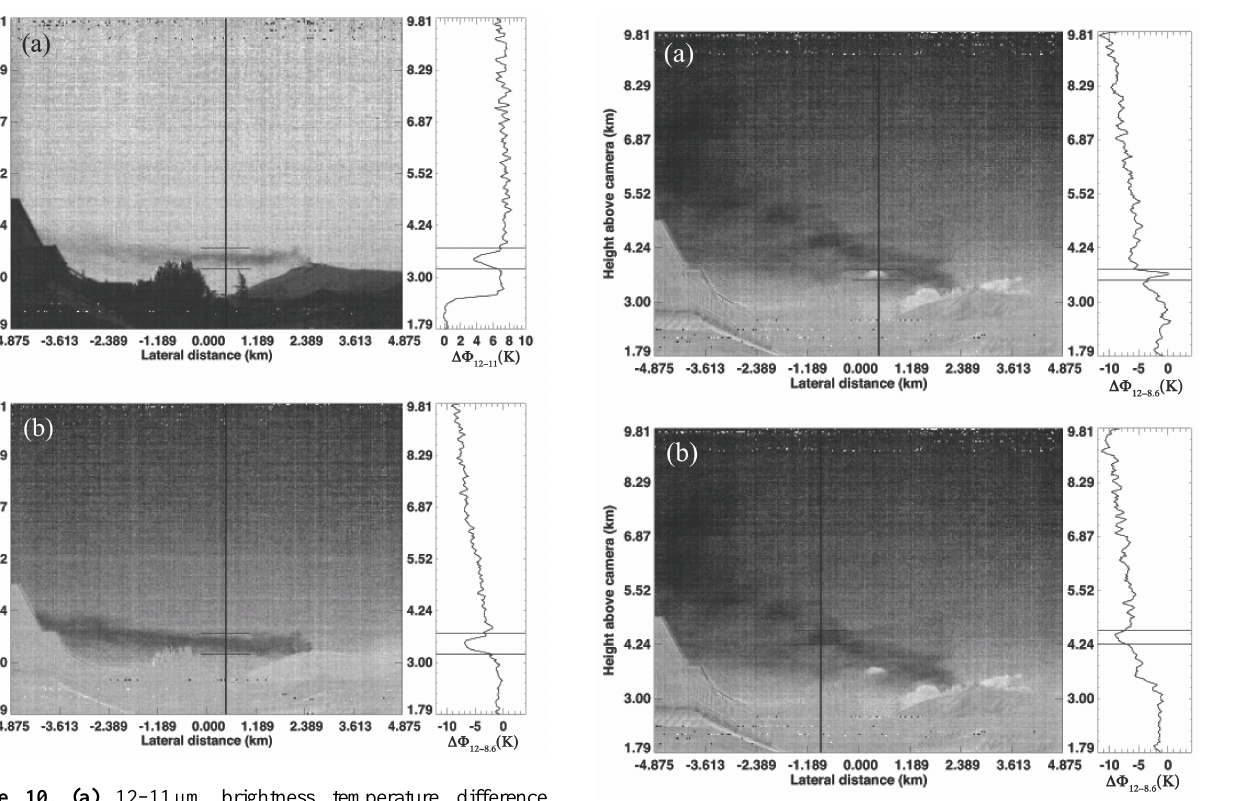
Figure 11. (a) 12–8.6µm brightness temperature difference ( 18 12 , 8 . 6 ) image of the Mt Etna plume. The panel to the right shows a temperature-difference–height profile for an image column that intersects a small meteorological cloud. (b) As for (a) but the height profile now intersects a portion of the Etna SO 2 plume.